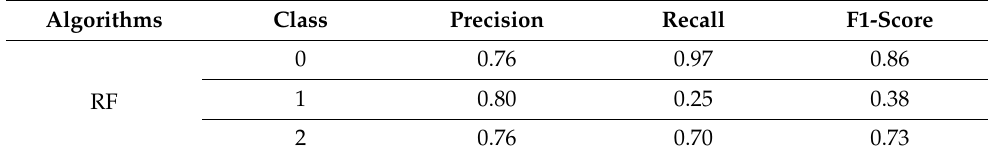
Table 7. Precision, Recall, and F1-score of the best algorithm.